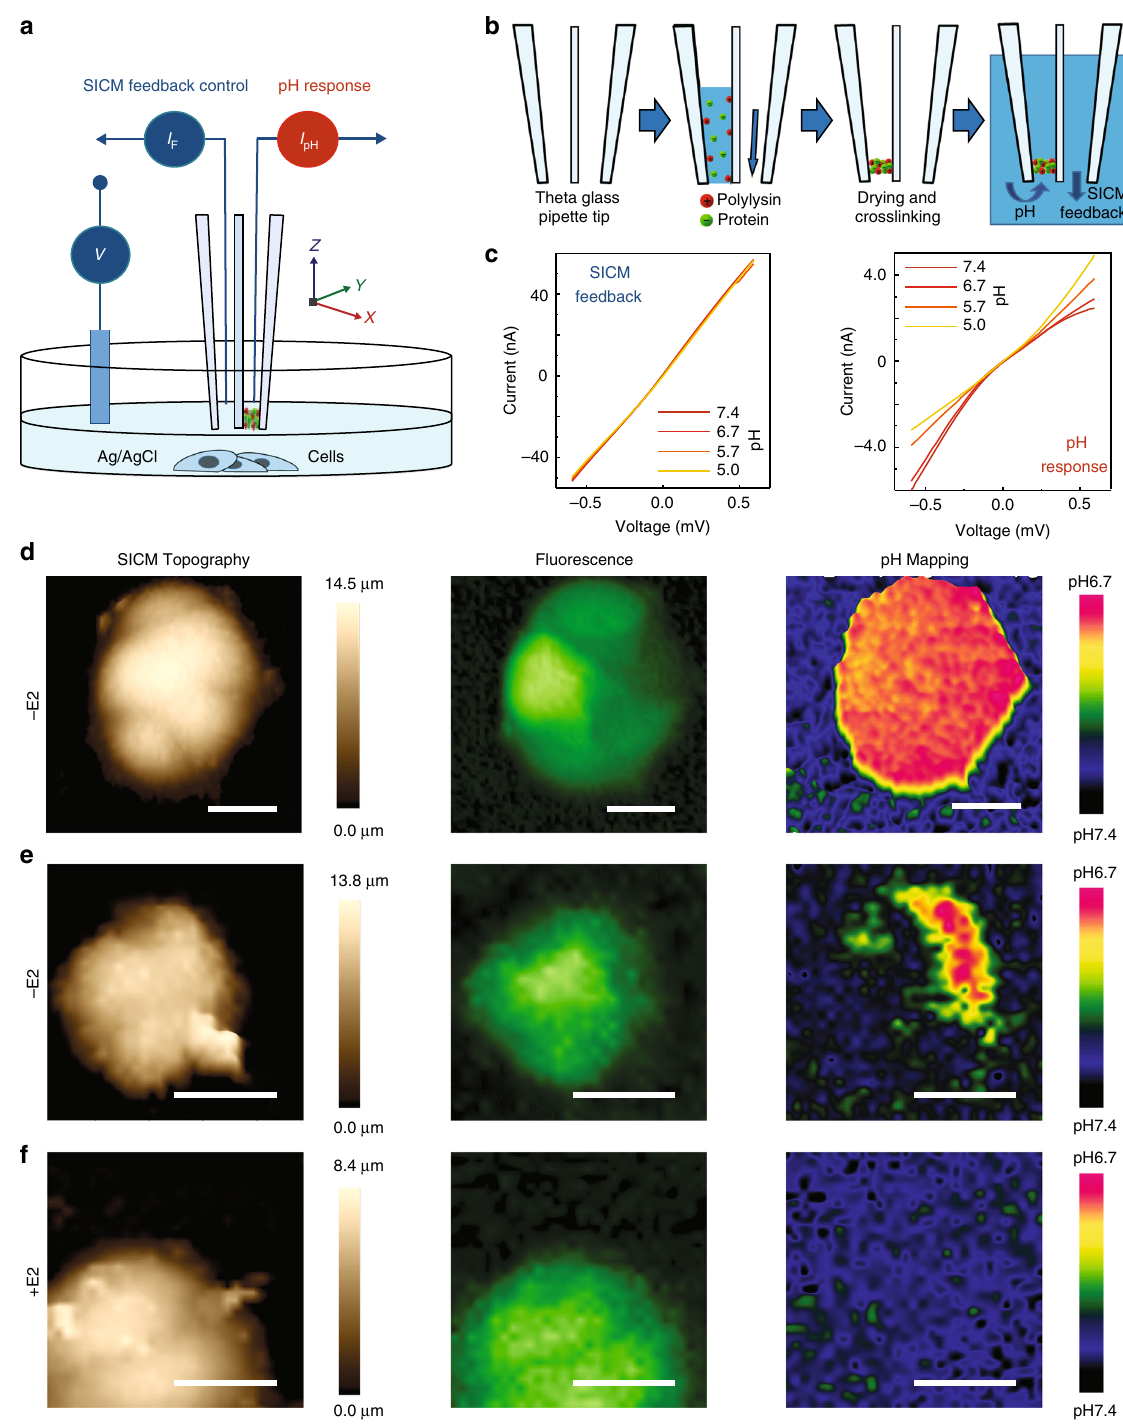
Fig. 3 Independent SICM feedback-controlled scanning and simultaneous 3D pHe mapping of living cells. a A schematic showing the operation of double- barrel nanoprobe for simultaneous SICM imaging and pH measurement. b A pH-sensitive nanomembrane is formed inside one barrel (pH-barrel) of a double-barrel θ quartz glass nanopipette, while the second barrel (SICM imaging -barrel) is kept open via applied back pressure during fabrication. c The ion-currents fl owing into two separated barrels of the generated double-barrel nanoprobe show different I – V responses to pH. d SICM imaging and 3D pHe mapping of a group of low-buffered CD44 GFP-high breast cancer MCF7 cells in estradiol-deprived medium ( − E2). The SICM topographical images (left), fl uorescence image (GFP, middle), and 3D pHe distributions (right) can be simultaneously obtained from a single scan. e Same as d but using a different group of estradiol-deprived ( − E2) CD44 GFP-high cells. f Same as d but using a group of CD44 GFP-high cells under estradiol-supplemented culture ( + E2). Scale bars represent 20 µ m. Intensity of fl uorescence images have been